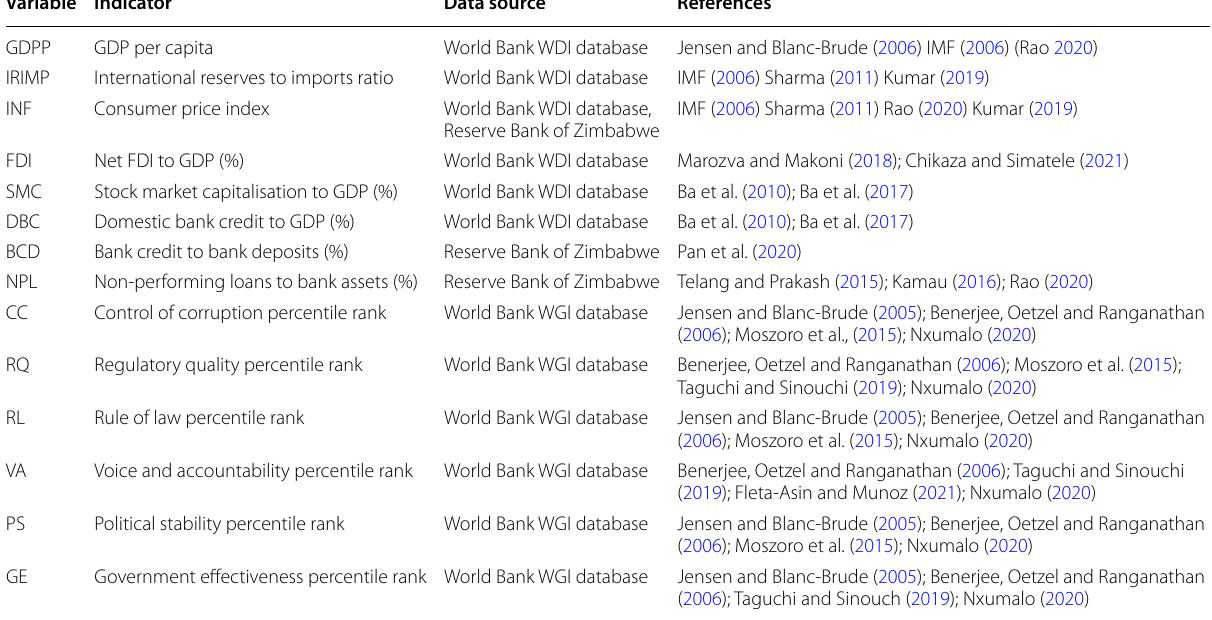
Table 2 Explanatory variables. Source: Authors’ own compilation Variable Indicator